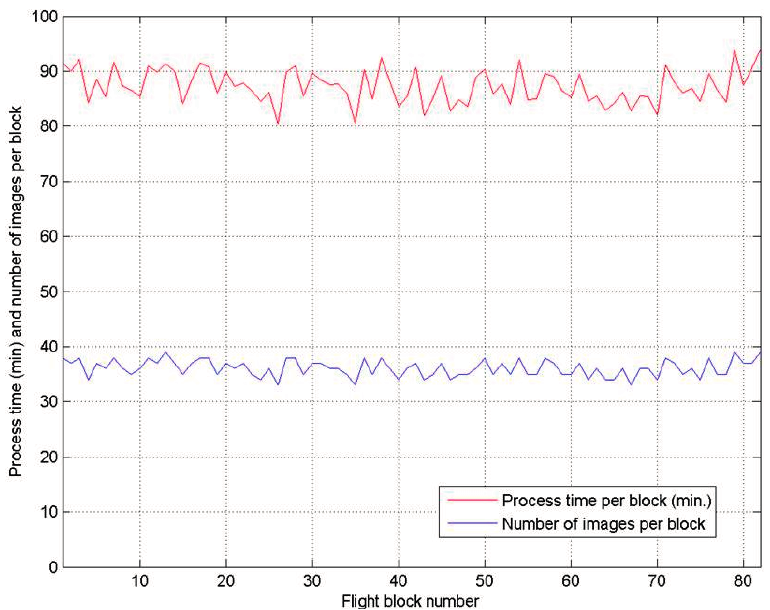
Figure 6. Process time and number of images per block.